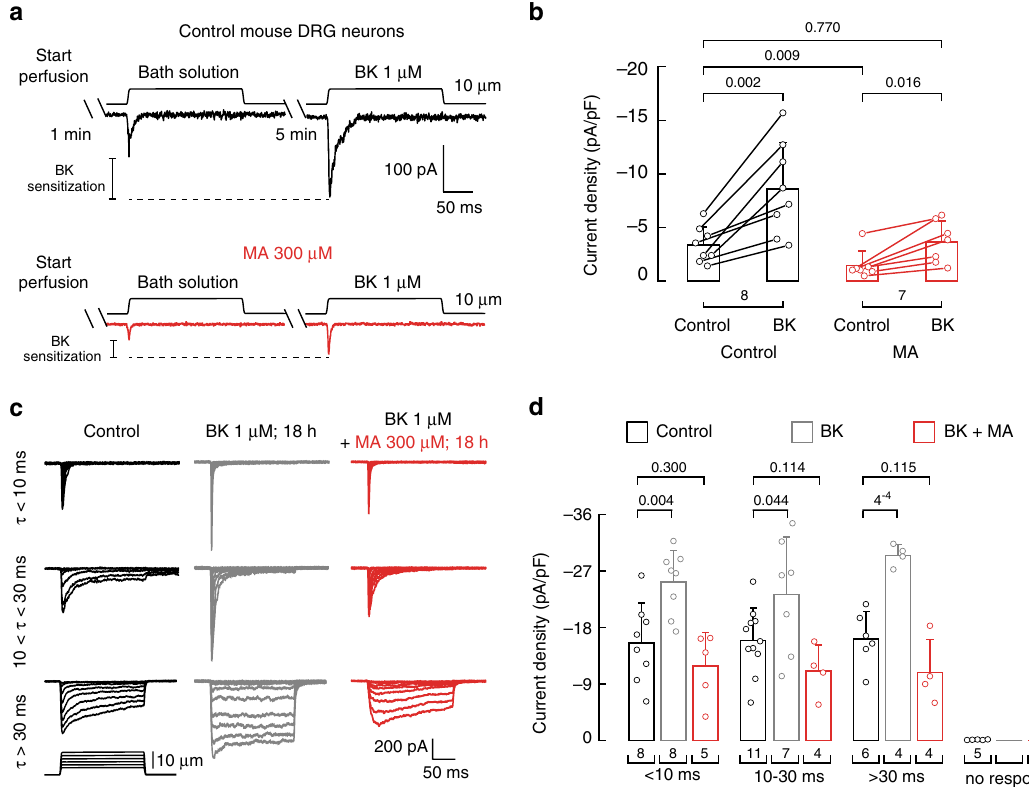
Fig. 6 MA recovers normal mechanical response in sensitized mouse DRG neurons. a Representative whole-cell patch-clamp traces of mechanically activated currents after perfusing bath solution (60 s) and bath solution containing bradykinin (BK; 300 s; 1 µ M) consecutively to control (black) and MA (300 µ M)-treated mouse DRG neurons. b Current densities elicited by 10 µ m displacement of control and MA (300 µ M)-treated mouse DRG neurons perfused for with bath solution (60 s) and with bath solution containing bradykinin (BK; 300 s, 1 µ M) consecutively. Bars are mean ± SD. Data samples are paired. n is denoted above the x -axis. Two-tailed paired t -test for untreated control before and after BK, two-tailed unpaired t -test for untreated control and MA-treated neurons after BK, two-tailed Mann – Whitney for untreated control and MA-treated control before BK, and two-tailed Wilcoxon matched-pairs signed-ranks test for MA-treated neurons before and after BK. c Representative whole-cell patch-clamp recordings elicited by mechanical stimulation (at